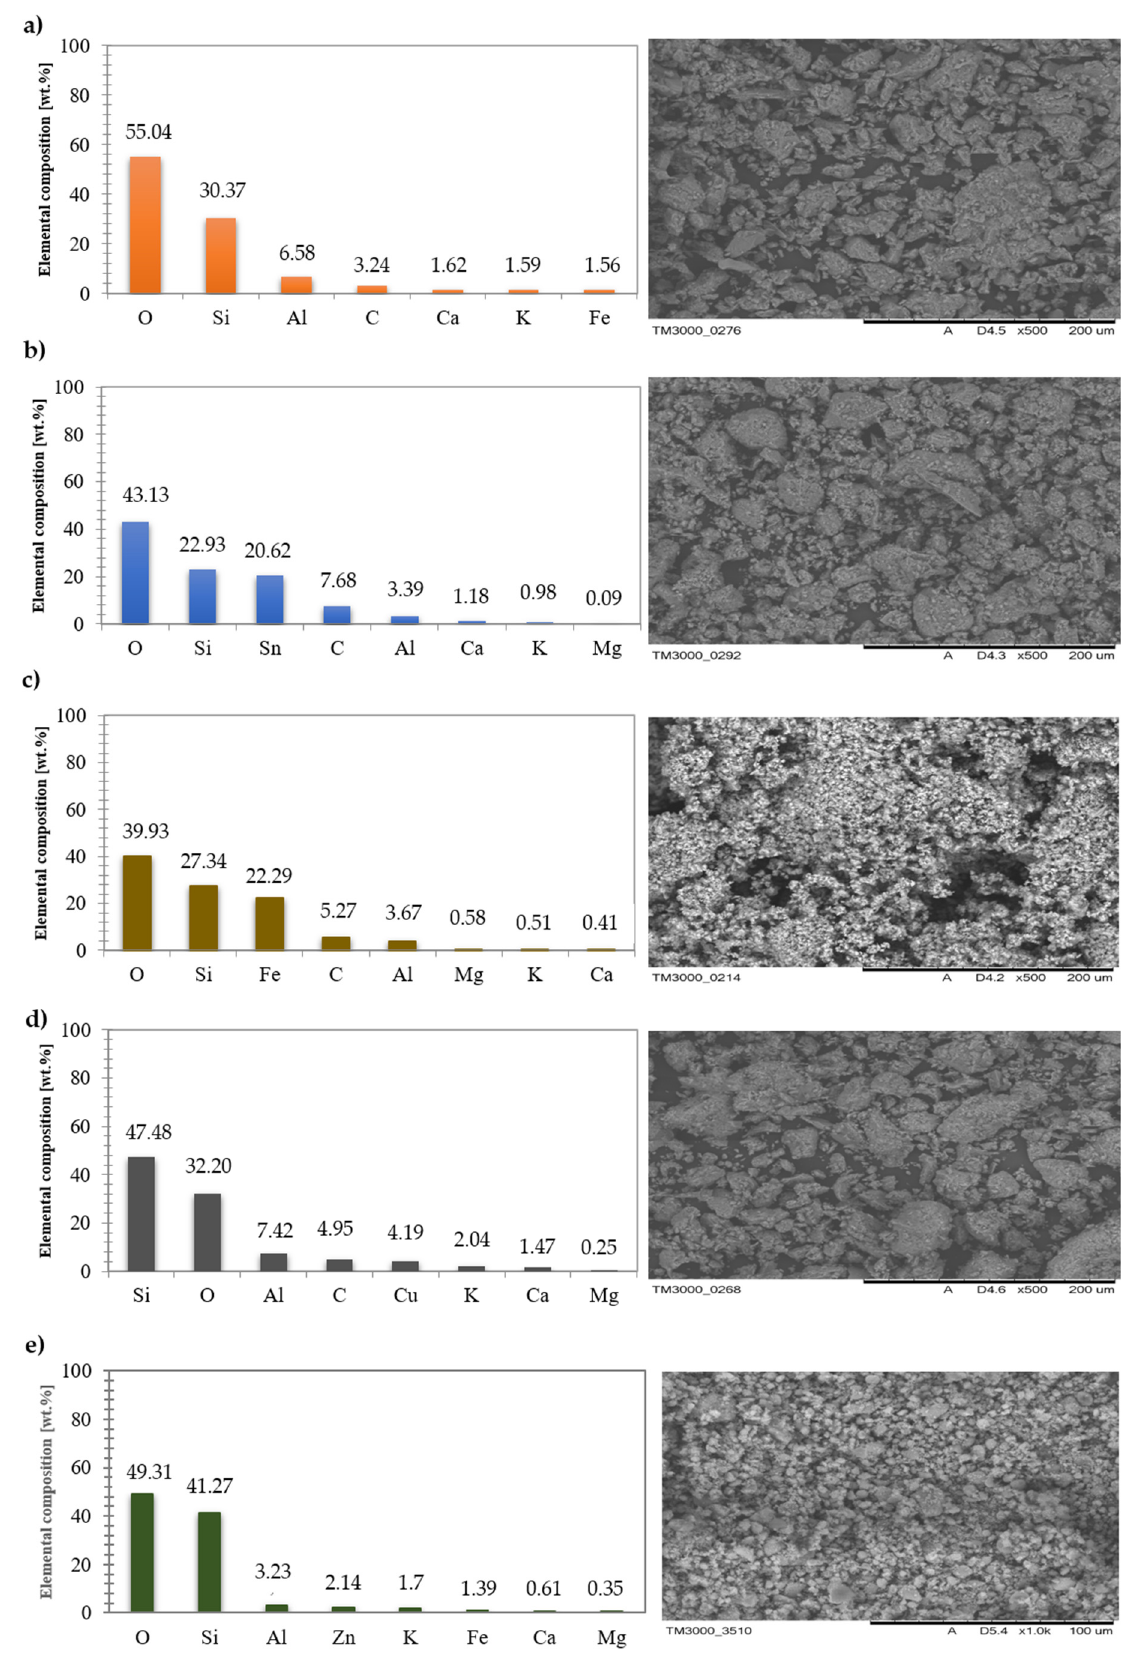
Figure 7. SEM and EDS for CLI zeolites with the metals ( a ) -, ( b ) Sn, ( c ) Fe, ( d ) Cu, ( e ) Zn.